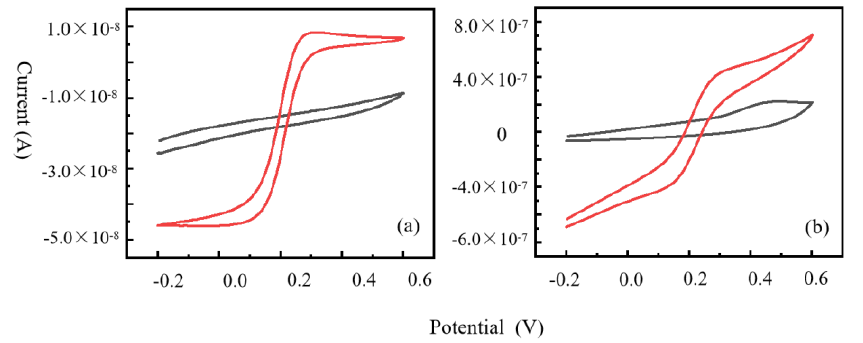
Figure 3. Cyclic voltammograms of inner ( a ) NRE 1 and ( b ) outer NRE 2 at a 100 mV/s scan rate. Signal (red curve) is generated with a 5 mM K 4 Fe(CN) 6 / 5 mM K 3 Fe(CN) 6 redox couple in 1M KCl. The background current (black curve) is generated in 1 M KCl.